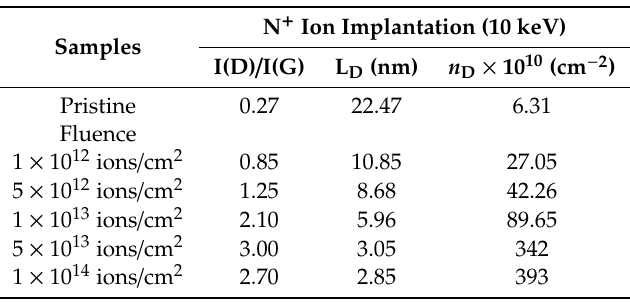
Table 2. Intensity ratios of D and G peaks (I(D) / I(G)), mean distance between defects in graphene (L D ) and defect density ( n D ) in N + ion-implanted EG /